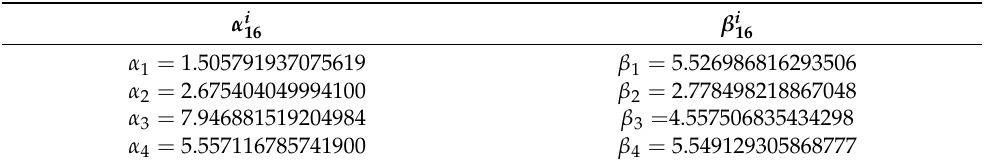
(cid:16) (cid:17) α i , β i . 16 16